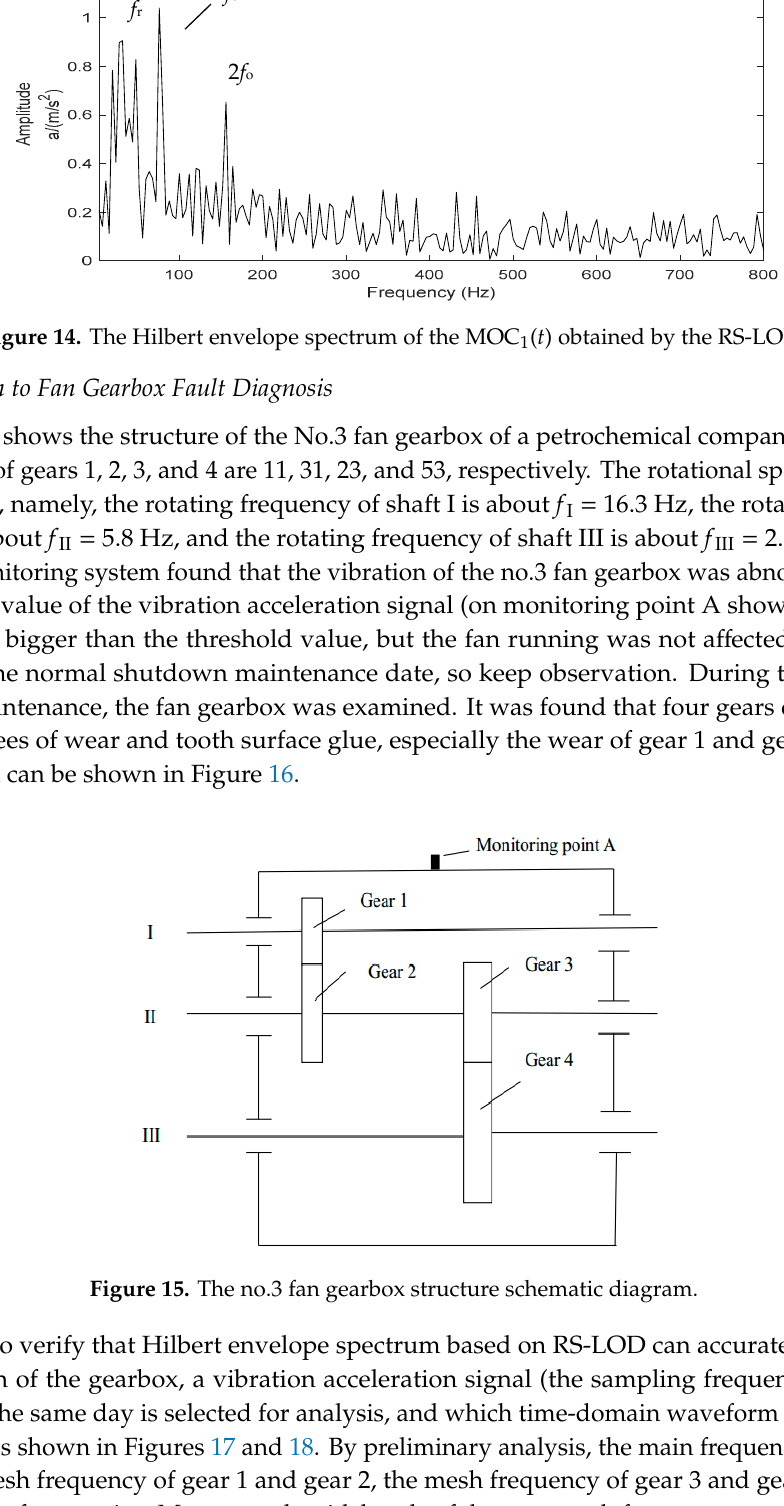
Figure 15. The no.3 fan gearbox structure schematic diagram.